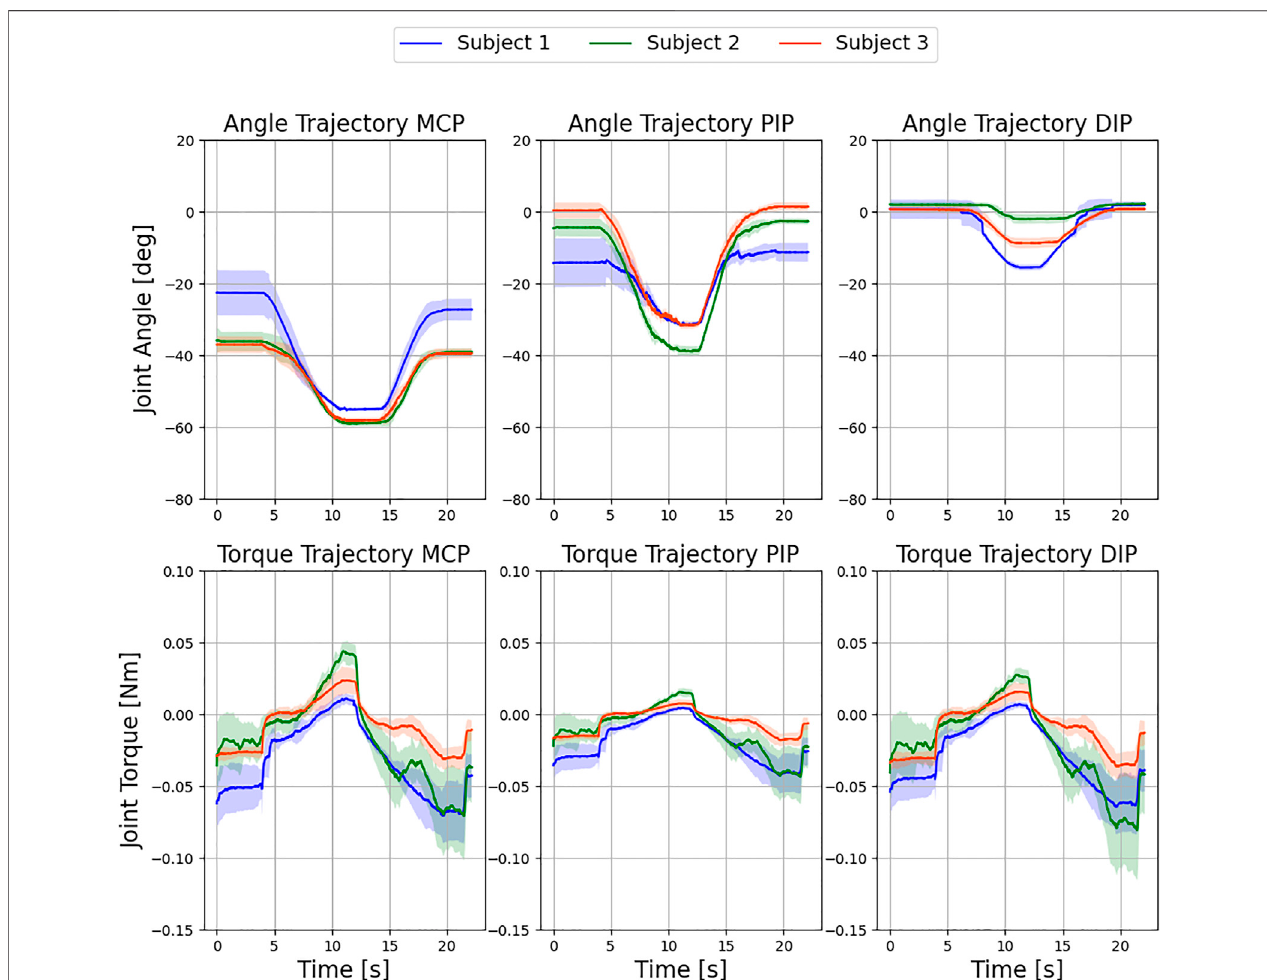
FIGURE 13 | Evaluation of exemplary movement of the three fi ngers with the exoskeleton over six independent test cycles. Displayed are the resulting mean ± standard deviation over all cycles for the respective subjects. No control intervention occurred.